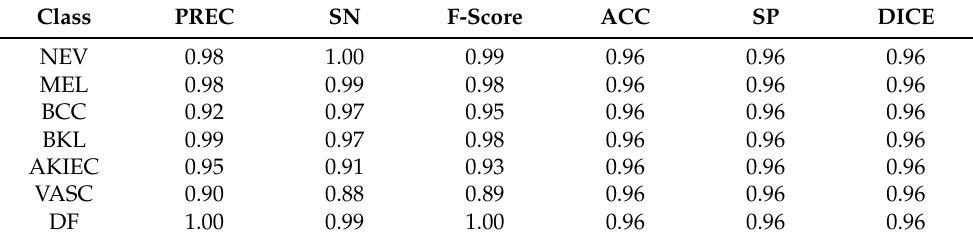
Table 4. The optimized CNN model evaluated on the ISIC2018 dataset.